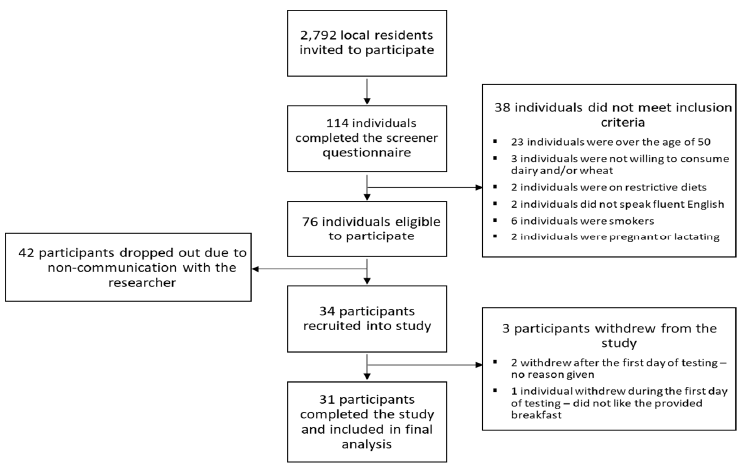
Figure 1. Consort diagram of participant recruitment, disposition status and